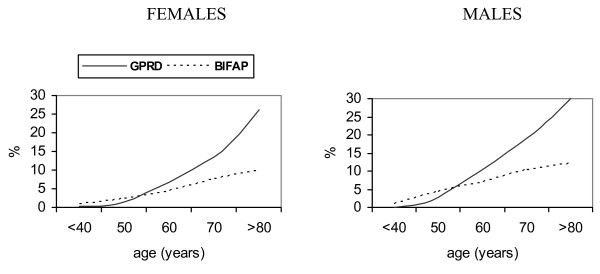
Prevalence of aspirin use for cardioprotection in the UK (General Practice Research Database; GPRD) and Spain (Base de Datos para la Investigación Farmacoepidemiológica en Atención Primaria; BIFAP) by age for females and males.